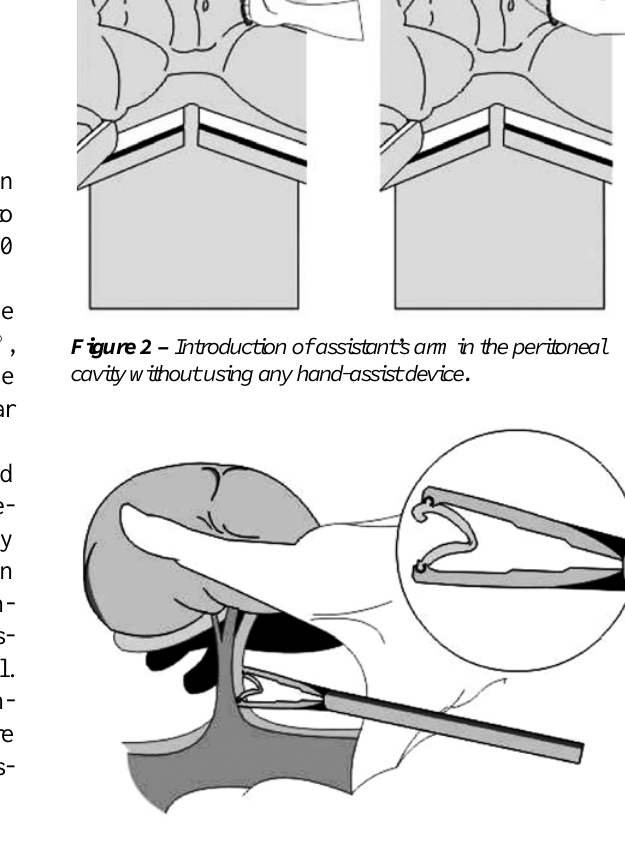
Figure 3 – Renal pedicle exposure between the assistant hand’s